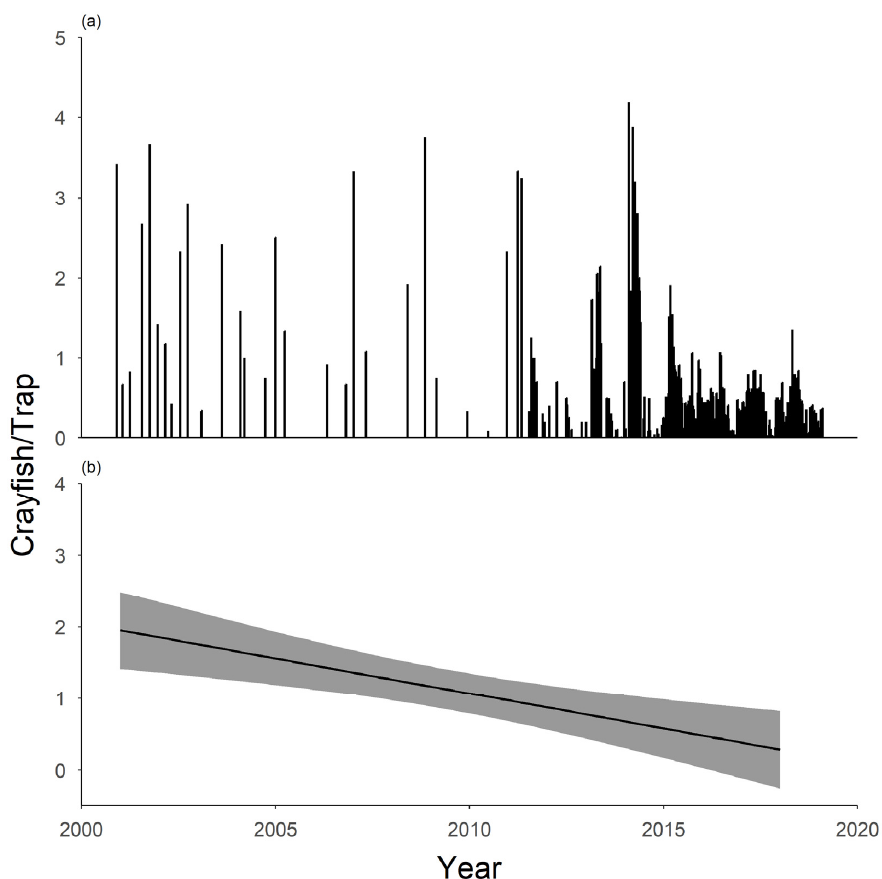
Figure 6. The trend in number of gapped ringed crayfish Faxonius neglectus chaenodactylus captured in Tumbling Creek Cave (17 March 2001–05 September 2018). The number of crayfish capture per trap